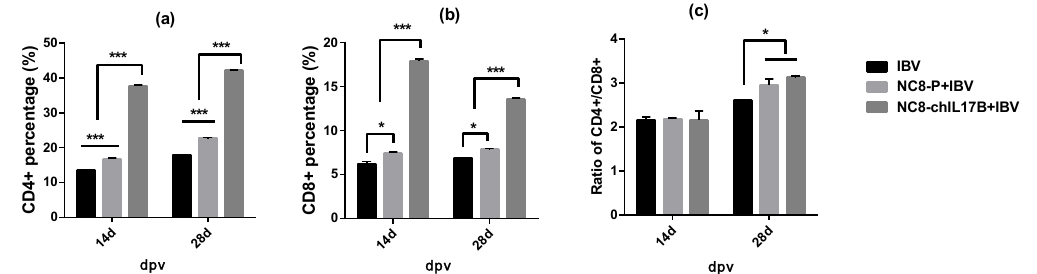
Figure 5. CD4 + and CD8 + T cells in the blood of the experimental chickens on the 14th and 28th dpv. ( a ) The percentage of CD4 + T cells in the peripheral blood of the experimental chickens. ( b ) The percentage of CD8 + T cells in the peripheral blood of the experimental chickens. ( c ) The CD4 + / CD8 + ratio. Tukey’s multiple comparison test was used for statistical analysis; * p < 0.05, *** p < 0.001.